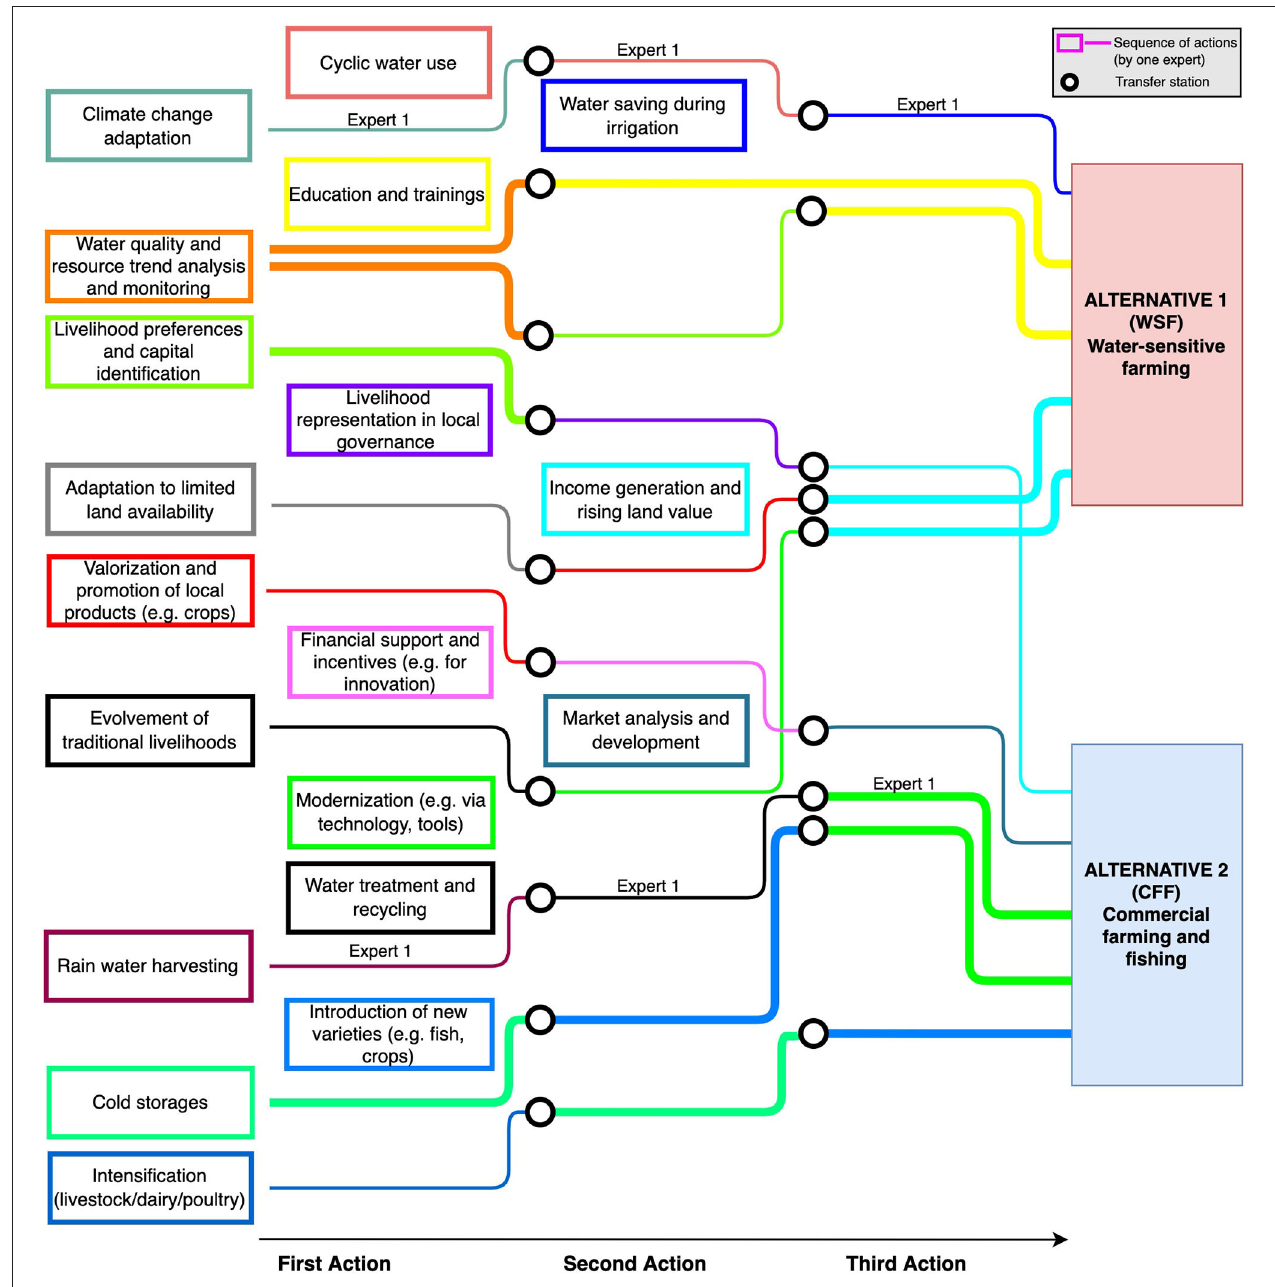
FIGURE 6 | Pathways towards the experts’ alternative livelihood